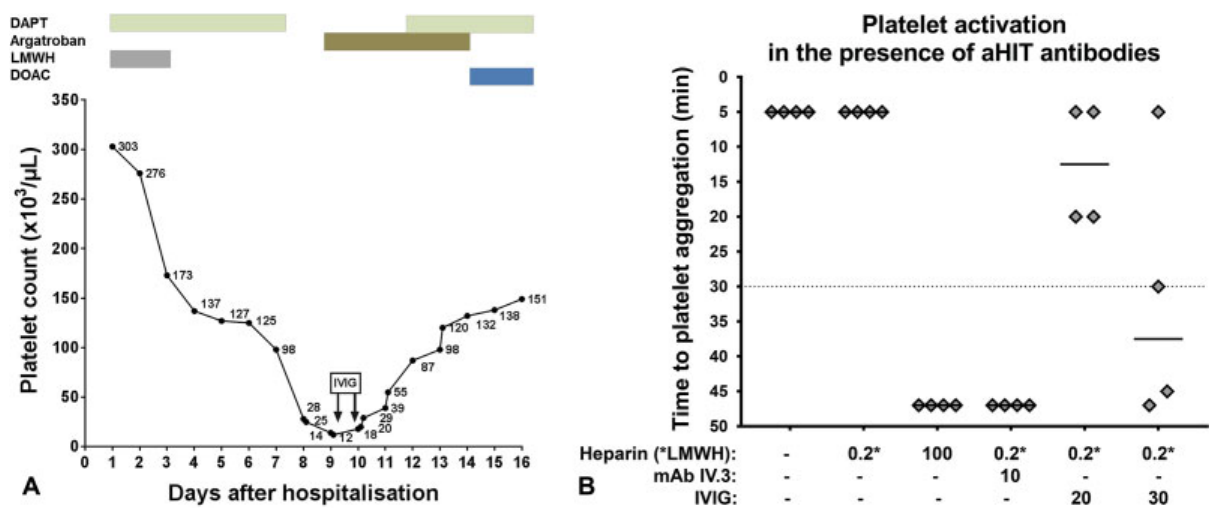
Fig. 1 ( A ) Recovery in platelet count in an autoimmune HIT after transcatheter aortic valve. (B) The impact of IVIG on platelet activation by autoimmune HIT antibodies. Patient ’ s serum was incubated with platelets from four healthy donors in the presence of 0.2 IU/mL LMWH (reviparin) and different concentrations of IVIG. Platelet activation was determined by measurement of time until platelet aggregation in the HIPA assay. DAPT, dual antiplatelet therapy; DOAC, direct oral anticoagulant; HIT, heparin-induced thrombocytopenia; IVIG, intravenous immunoglobulin; LMWH, low-molecular-weight heparin; MAb IV.3, Fc gamma receptor IIa blocking monoclonal